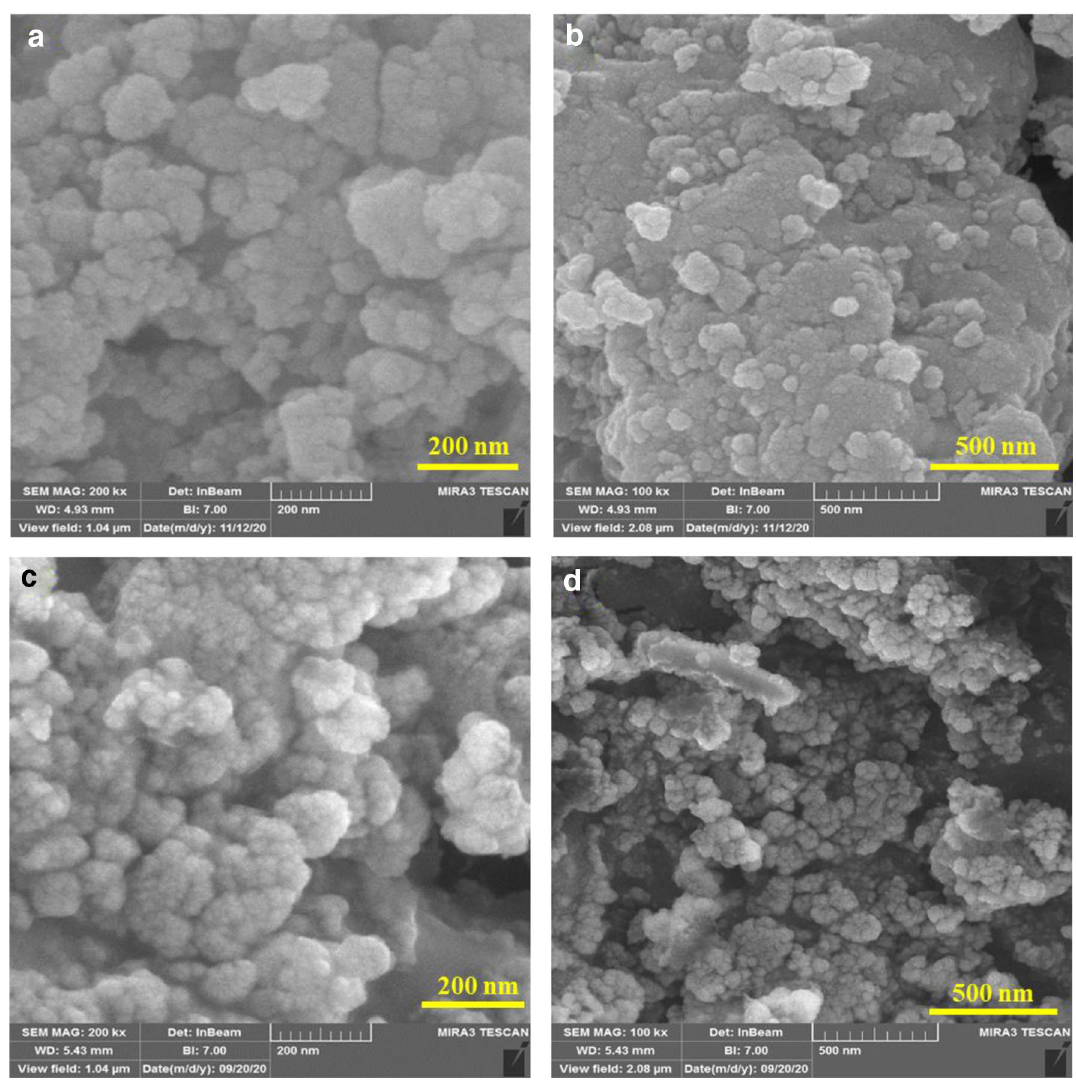
Figure 11. FE-SEM images of MIL-53(Al)-NH 2 ( a , b ) and MIL-53(Al)-N(CH 2 PO 3 H 2 ) 2 ( c , d